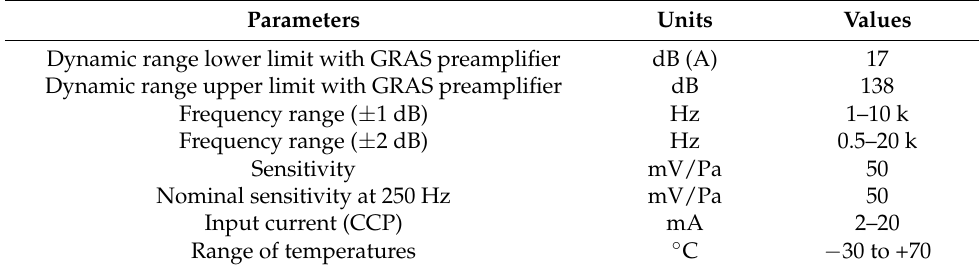
Table 1. Summary of basic parameters of G.R.A.S. 46AZ microphone.